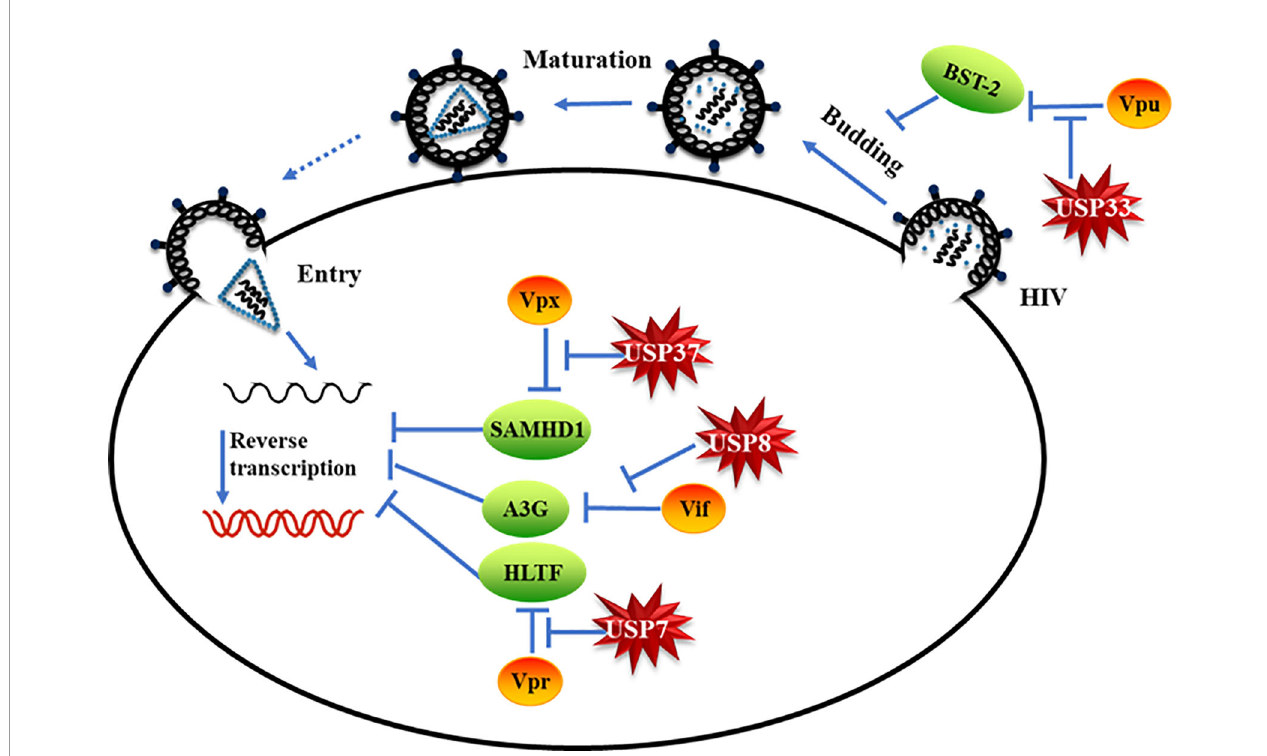
FIGURE 6 | Speci fi c deubiquitinating enzymes suppress viral protein-mediated evasion of cell host restriction. Model of speci fi c deubiquitinating enzymes suppressing HIV/simian immunode fi ciency virus (SIV) accessory protein-mediated cell host restriction factor